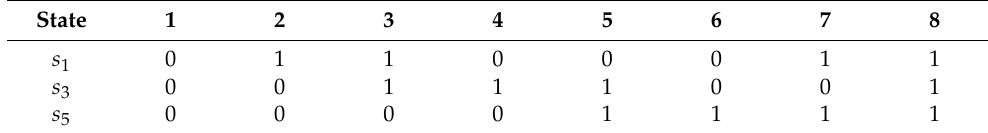
Table 2. Switching states AFE